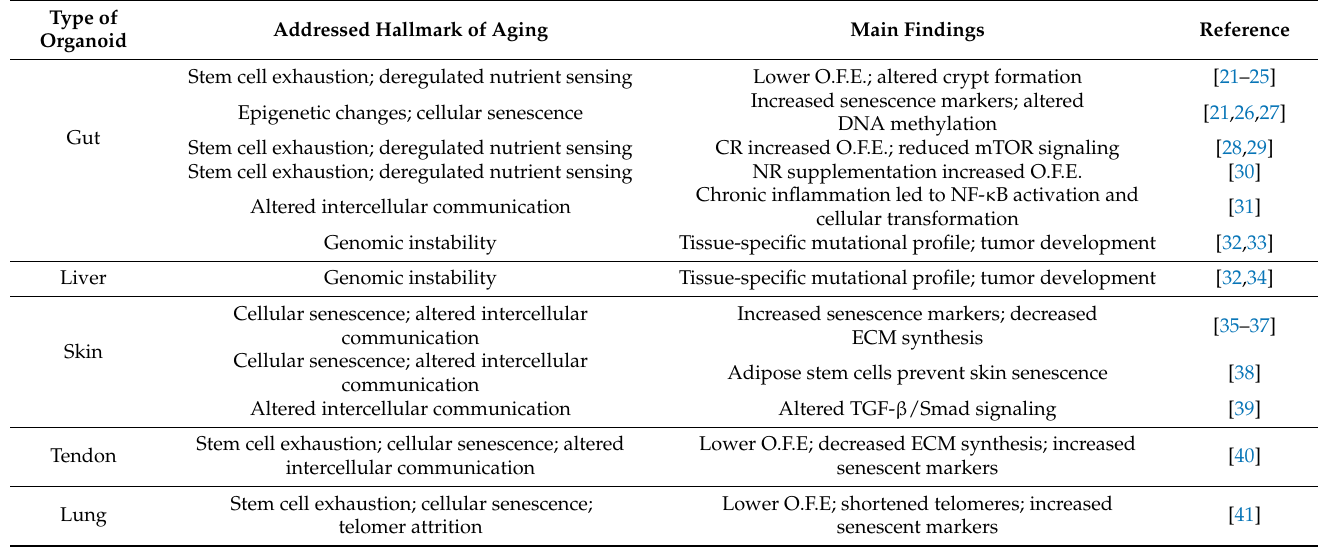
Table 1. Summary of studies using organoids to model